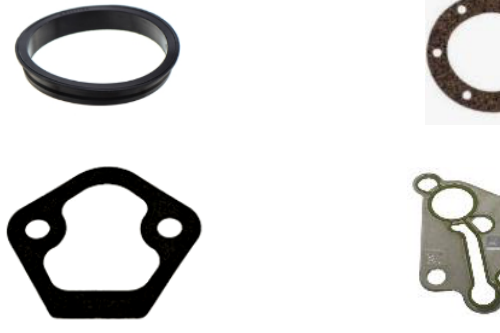
Figure 1. Selection of gasket geometry, from simple to complex.